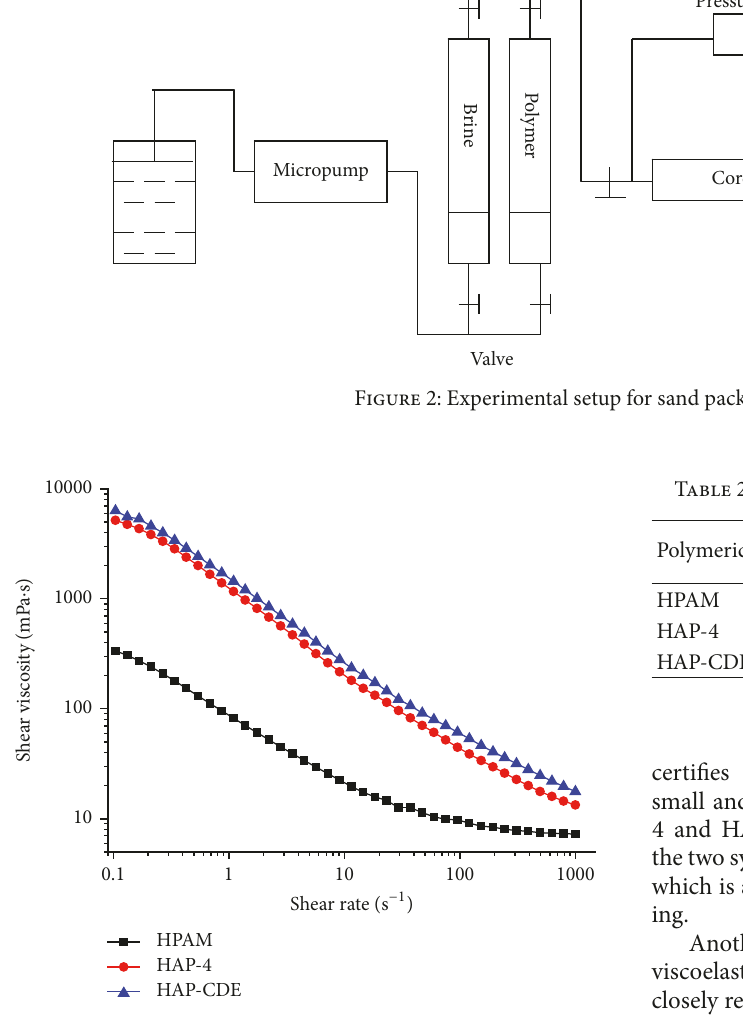
Figure 3: Shear rate dependence of the three aqueous polymeric solutions (0.2wt%, 25 ∘ C).